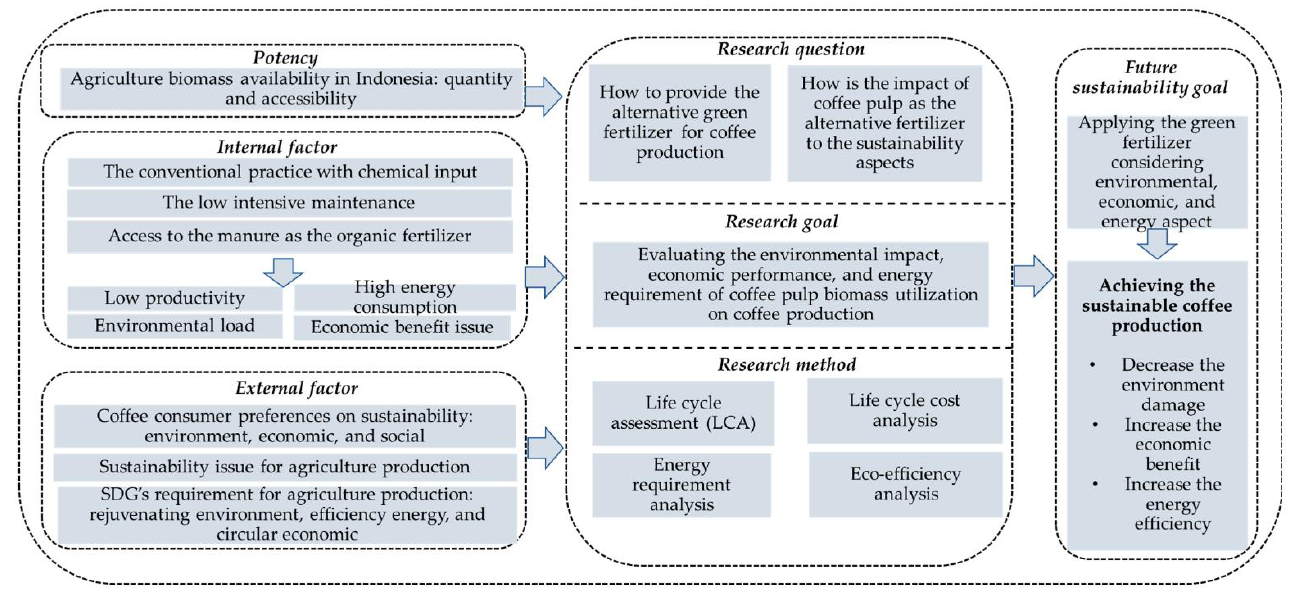
Figure 1. The research framework of the study.